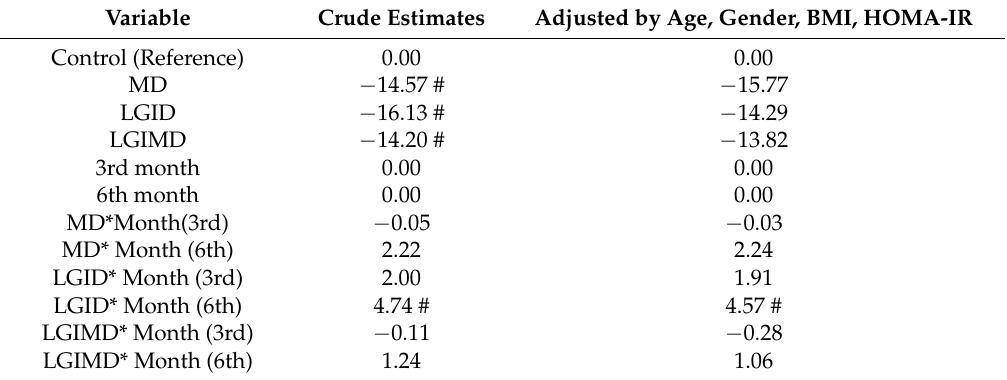
Table 3. Overall Effect of Different Diets on irisin Levels MEDIDIET, Castellana Grotte, BA, Italy 2009.